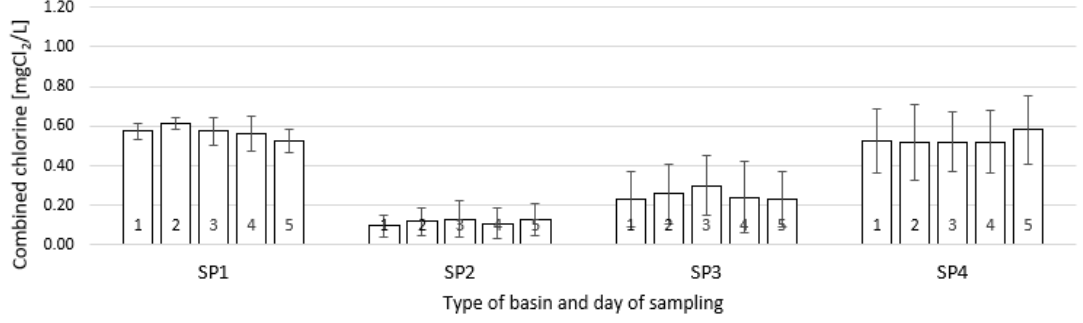
ff erent swimming